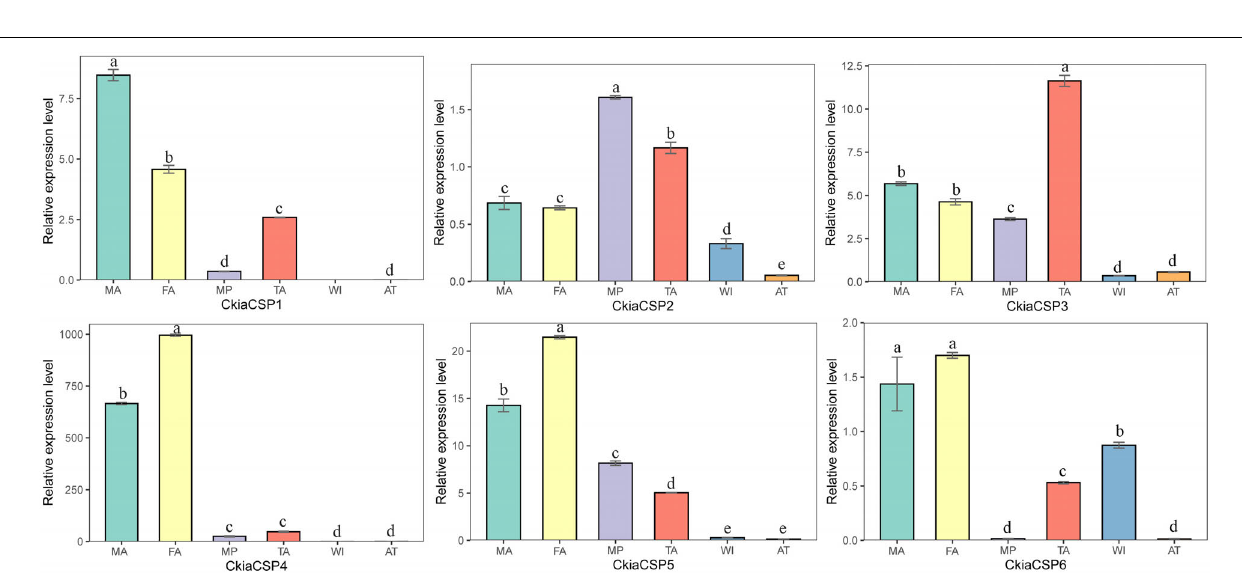
FIGURE 10 | Relative expression levels of CSPs in different tissues of C. kiangsu as measured by RT-qPCR. FA, female antennae; MA, male antennae; MP, maxillary palps; TA, tarsi; WI, wings; AT, thoraxes-abdomens. The bar represents standard error and the different small letters above each bar indicate significant differences ( P <